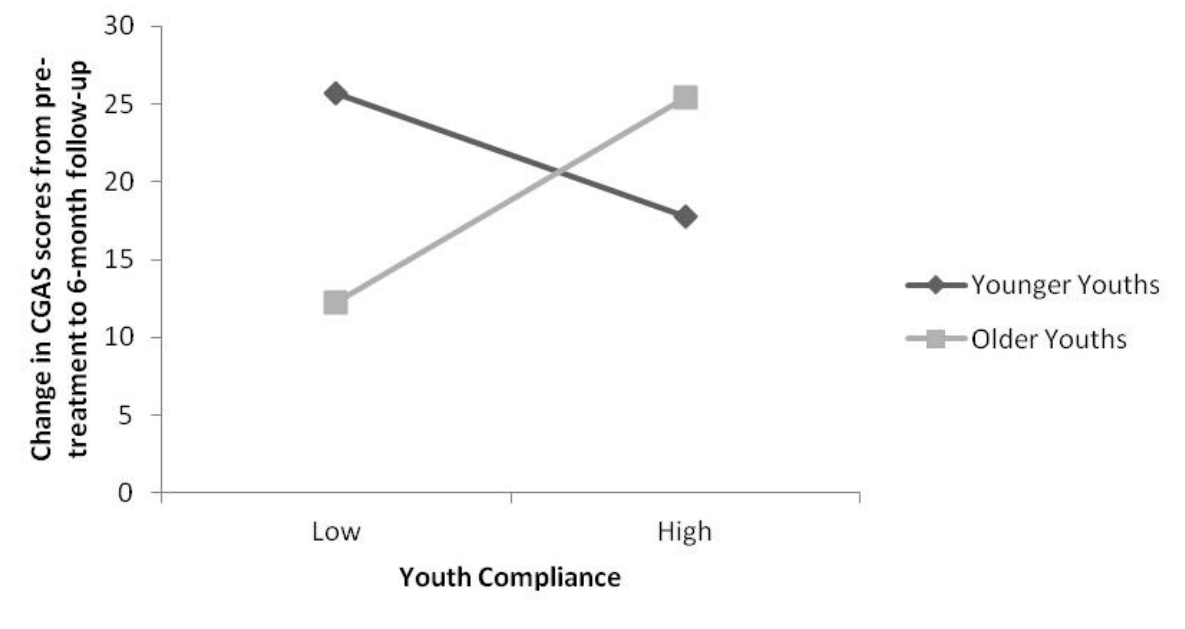
Figure 4. Conditional effects of youth age on the relationship between youth compliance and change in child global functioning, as measured by the Children’s Global Assessment Scale (CGAS), from pretreatment to 6-month follow-up. Younger/older age represents -/+1 SD (2.5 years) below/above the mean (12.12